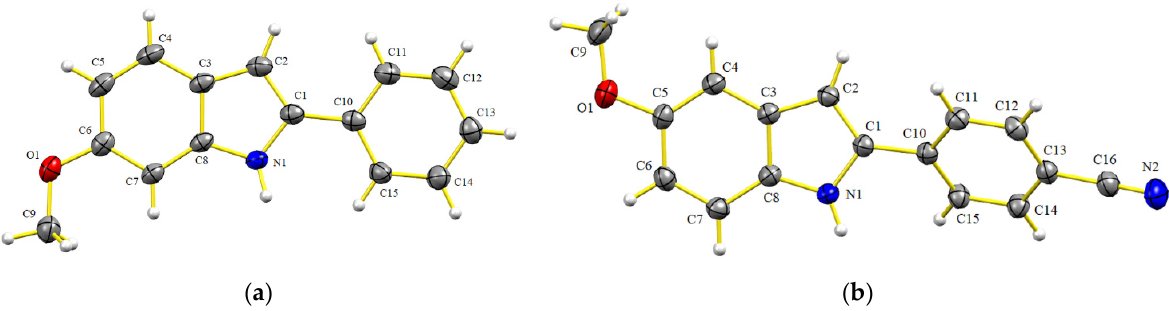
Figure 3. Structures of 6e ( a ) and 6l ( b ) as determined by single X-ray diffraction crystallography (ellipsoids at the 30% probability level).